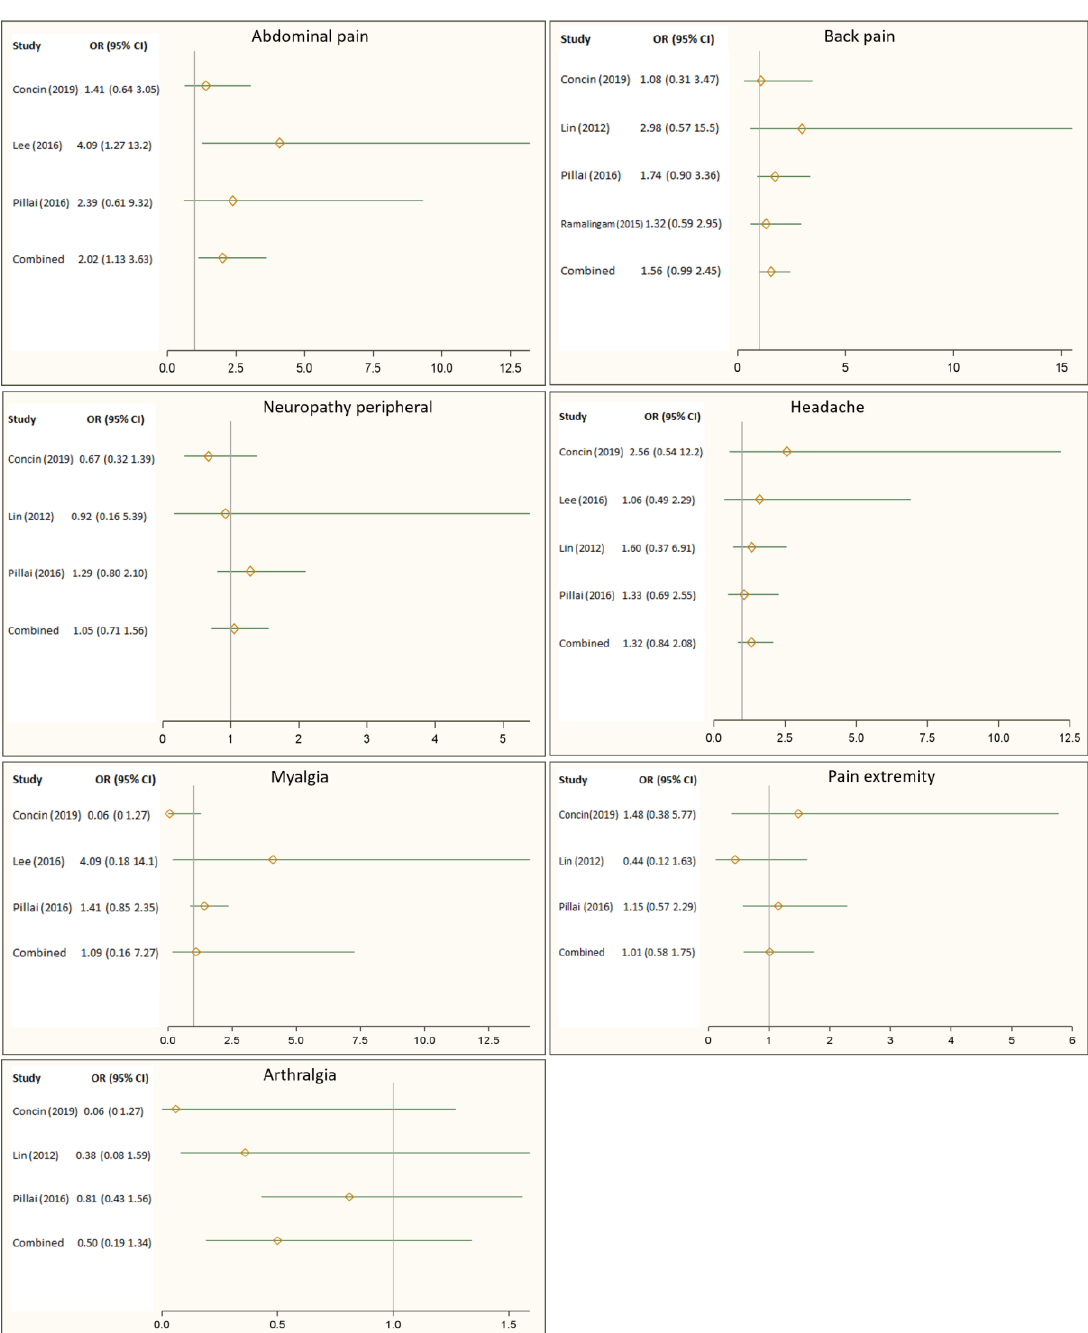
Figure 2. Impact of Heat shock protein 90 (Hsp90) inhibitors on back pain, headache, peripheral neuropathy, abdominal pain, myalgia, pain in the extremities, and arthralgia.